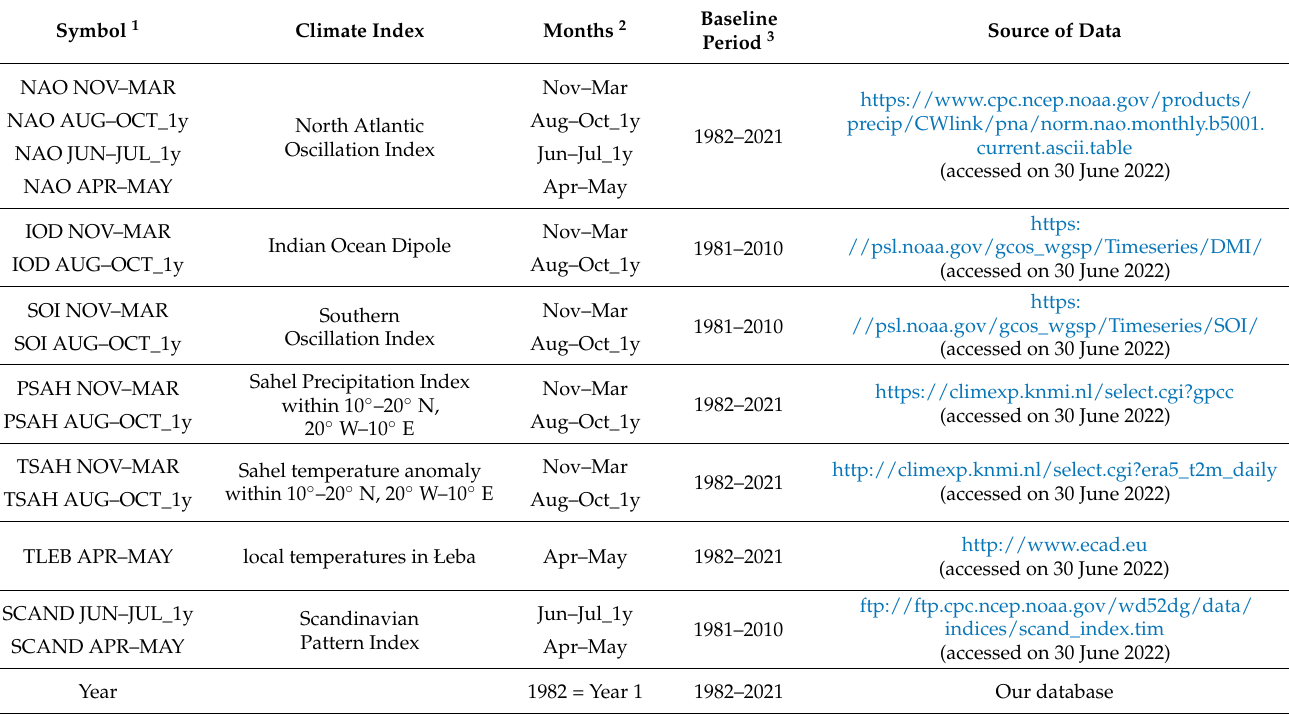
Table 1. Climate indices used as explanatory variables in modelling the timing of spring passage (23 March–15 May) of long-distance migrants over 1982–2021 at Bukowo, Poland. The local tempera- tures in Łeba (TLEB) were observations from the local weather station in Łeba; the remaining climate variables were reanalysed spatial data based on observations from weather stations and weather models, provided by the weather services at the listed